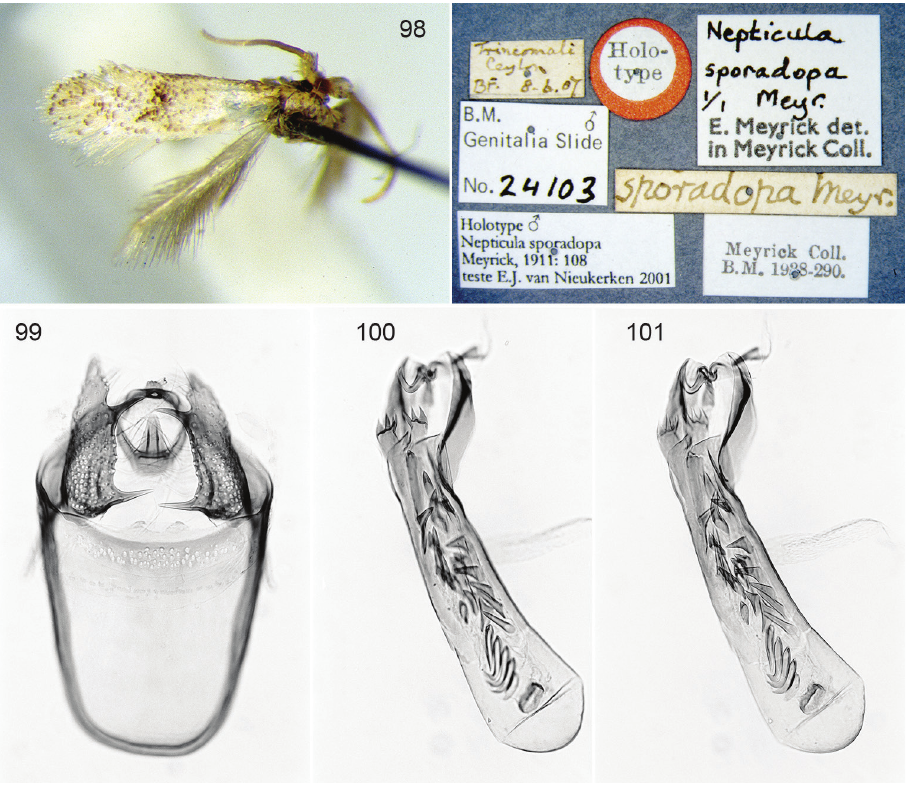
Figures 98–101. Fomoria sporadopa (Meyrick, 1911), holotype male, labels and male genitalia. Translation of the original description in Japanese by Matsumura: “Body and wing with grey-yellow and white with reflection. Head orange yellow, both sides silvery white. Antenna grey white. Forewing darker with three bands. One near wing base, one in middle and a little one outwards. Third fascia at the apex. Terminal and dorsal cilia grey-yellow white. Costal fringe darker. Hindwing darker. Legs dark grey. Seems to be the smallest moth in Japan. Early September. Hokkaido.” [ Translated by Liu Youqiao, August 1996 ] 60 Acalyptris falkovitshi (Puplesis, 1984). We synonymize here Microcalyptris arenosus Falkovitsh, 1986 and M. vittatus Puplesis, 1984, after earlier M. turanicus Puplesis, 1984 was synonymized with A. falkovitshi (van Nieukerken 2010). We act as First Reviser (ICZN article 24.2) to identify M. falkovitshi as having priority to the other species that were published in the same paper ( vittatus and turanicus ). The slight dif- ferences given earlier (Puplesis 1990; 1994) do not hold when a larger sample is stud- ied: the sclerotization of the T-shaped sclerites on segments 4–8 may vary, probably depending on age. This is the larger species in this group, usually with a longitudinally brown stripe on forewings, a pointed gnathos and conspicuous tufts on tergites